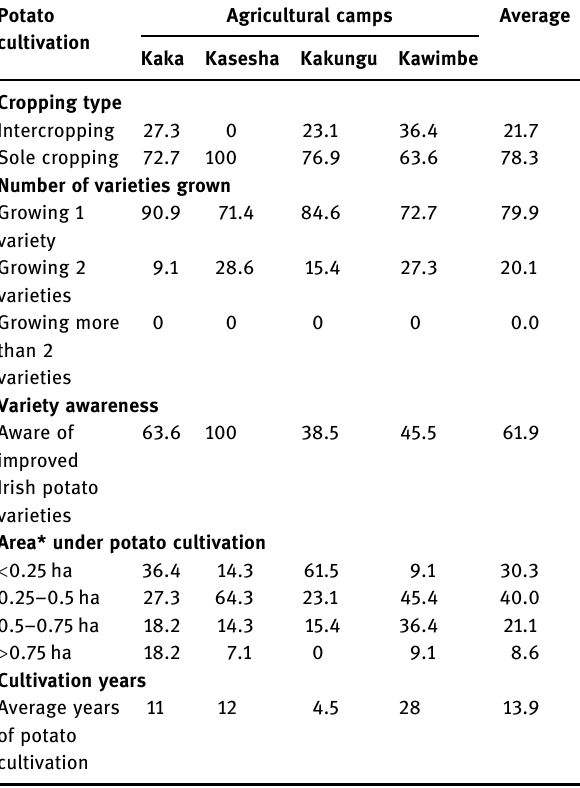
Table 1: Description of demographic household characteristics of sampled respondents ’ households in Mbala district during August